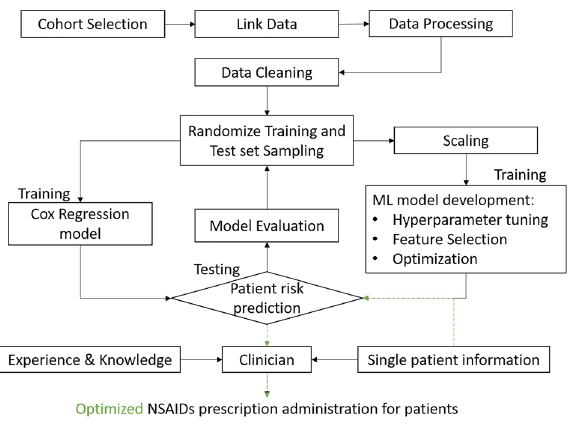
Figure 1. The machine learning workflow and contribution of our study. The figure was created using Microsoft PowerPoint 365, available from: https:// office. micro soft. com/ Power